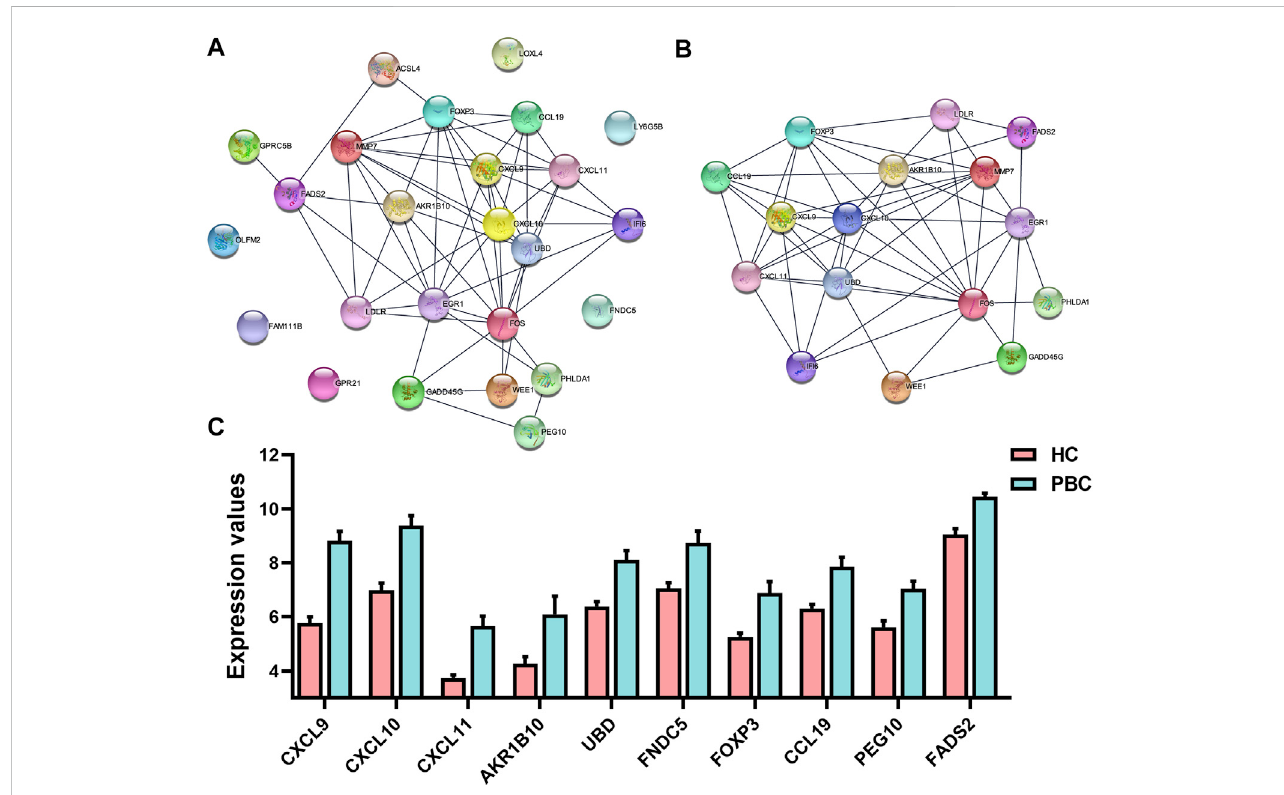
FIGURE 4 The PPI network and themost signi fi cant module ofDEGs. (A) The PPI network ofDEGs wasconstructed using STRING. (B) The mostsigni fi cantmodule was obtained from the PPI network using MCODE in Cytoscape. (C) Expression changes of top 10 DEGs between PBC and HC samples based on the microarray dataset GSE61260. PPI, protein – protein interaction; DEGs, differentially expressed genes; PBC, Primary biliary cholangitis; HC, healthy control.